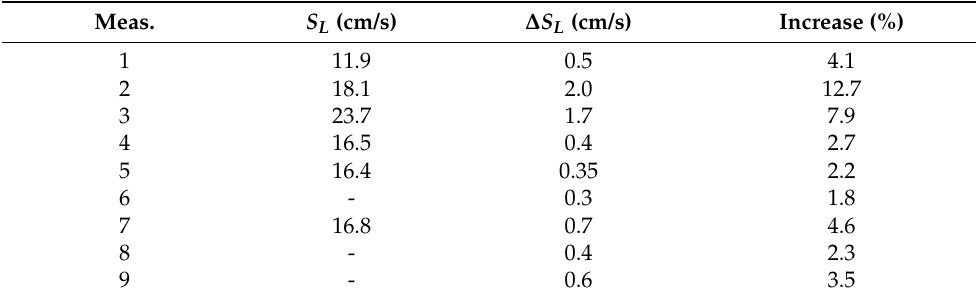
Table 3. Laminar burning velocities determined in this study for the experimental conditions given in Table 2. The increase in laminar burning velocity, ∆ S L , is in relation to the values at standard conditions, given in the text and presented in Figure